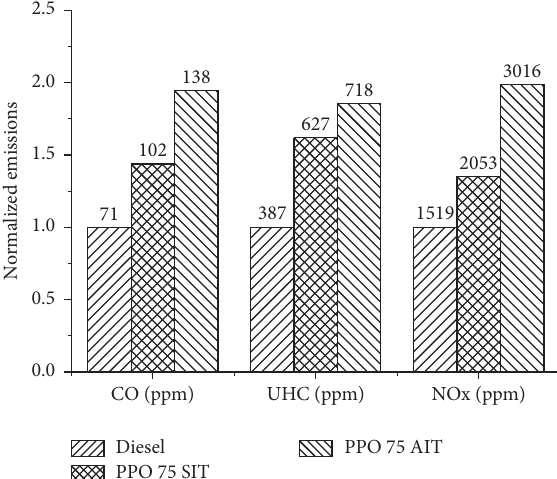
Figure 6: Normalized values of CO, UHC, and NOx